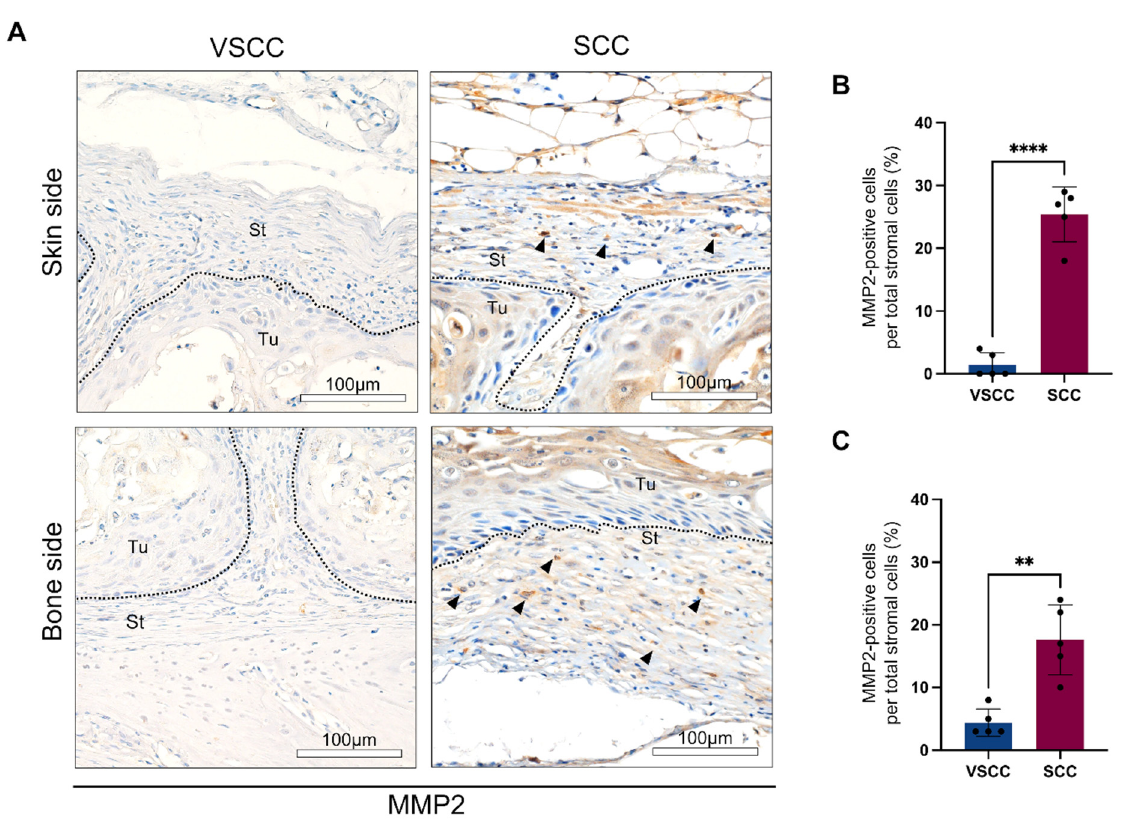
Figure 3. SCC-PDSX shows MMP2-positive cells’ infiltration in the periphery of tumor: ( A ) Repre- sentative images of MMP2 IHC: upper panel: skin side; lower panel: bone side (left panel: VSCC- PDSX; right panel: SCC-PDSX); ( B ) The rate of infiltrating MMP2-positive cells into the skin side of tumors; ( C ) The rate of infiltrating MMP2-positive cells into the bone side of tumors. Dotted lines represent the boundary of the tumor (Tu) and the stroma (St). VSCC, verrucous oral squamous cells carcinoma; SCC, conventional oral squamous cell carcinoma, PDSX, patient-derived stromal cells xenograft. Statistical analyses were performed using Student’s t- test, 2-tailed; ** p < 0.01, **** p < 0.0001. Dots in the plots represent the mean value of each mouse. Data are presented as the mean ± SD, n = 5.